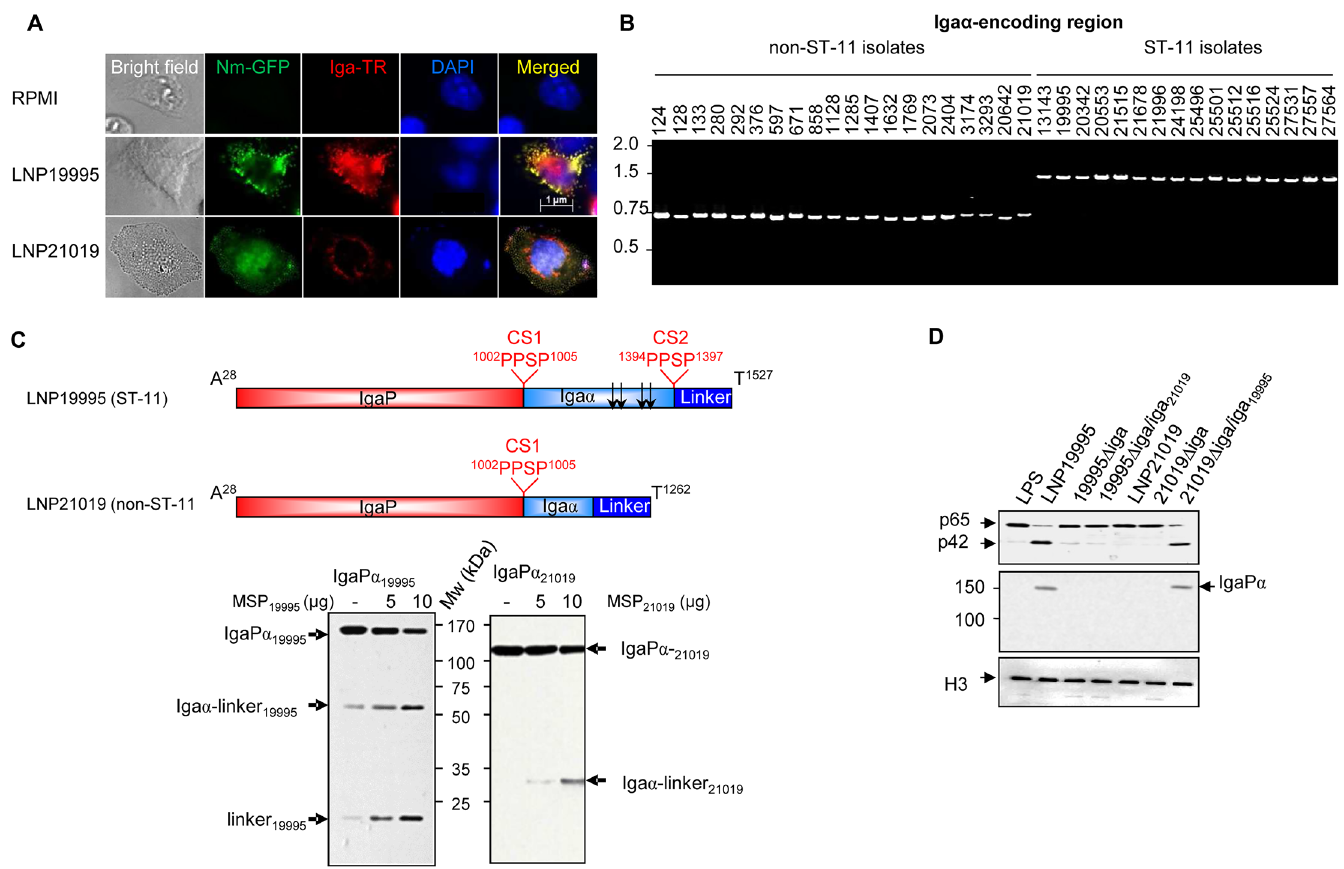
Fig 6. Non-ST-11 isolates release α -peptide-lacking IgA protease. (A) Subcellular localisation of IgA protease in infected cells. Hec-1B cells were infected with GFP-expressing LNP19995 or LNP21019 (green) or left uninfected. After 12 h of infection, cells were fixed with 4% PFA, permeabilised and stained with anti-IgaP polyclonal serum and Texas Red (TR)-conjugated anti-rabbit IgG (red). Nuclei were stained with DAPI. Fluorescence was analyzed using immunofluorescence microscopy. Data are representative of three independent experiments. (B) Analysis of ST-11 and non-ST-11 isolates by PCR using primers specific to α -peptide sub-domain. PCR products were amplified from genomic DNA of strains indicated above the gel, using the couple of primers alphaFwNhe / alphaRevSma. PCR products were separated by electrophoresis in 1% agarose gels and stained with ethidium bromide. PCR amplification generated amplicons of ~ 1500 bp in all ST-11 isolates, while amplicon sizes ranged between 687 and 770 bp in non-ST-11 isolates. Molecular sizes (kb) are indicated in the left side. (C) Upper panel. Non scaled schematic representation of the passenger subdomains of meningococcal IgA protease from isolates LNP19995 (ST-11) and LNP21019 (non-ST-11). The positions of autocatalytic processing sites and their sequences (PPSP) are indicated. Arrows indicate positions of NLSs in α -peptide of the ST-11 isolate. Lower panel. Five hundred nanograms of the C-terminal His 6 -tagged passenger domain of the strains LNP19995 (IgaP α 19995 ) or LNP21019 (IgaP α 21019 ) were mixed with 5 or 10 μ g of MSPs. After 3 h, the reaction mixtures were analyzed with immunoblot using anti-His tag mAb. The different cleavage products are indicated by arrows. Mw indicates the molecular weight. (D) IgA protease of ST-11 isolates restores the capacity of non-ST-11 isolates in cleaving nuclear p65. Each of the 19995 Δ iga and 21019 Δ iga were complemented with the heterologous iga allele of the WT strain LNP21019 and LNP19995, respectively. Hec-1-B cells were infected for 12 h with the parental WT strains, the isogenic iga knock-out mutant strains or the heterologous complemented strains. Nuclear fractions prepared from infected cells, were resolved by SDS-PAGE and were probed with anti-p65 mAb (N-terminal specific) or polyclonal serum anti-IgaP. LPS-treated cells were used as positive control for nuclear translocation of NF- κ B. Immunoblot with anti histone H3 was used as loading